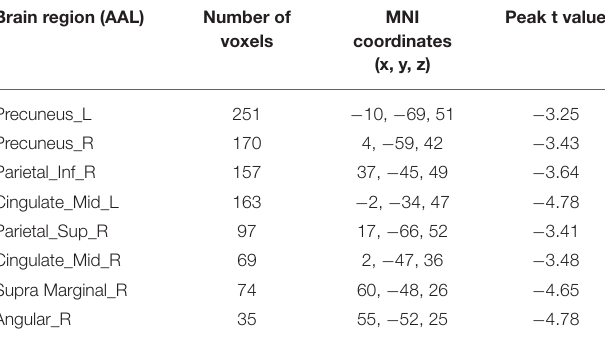
TABLE 2 | Brain regions showing significant differences in ALFF values between the RD and without RD